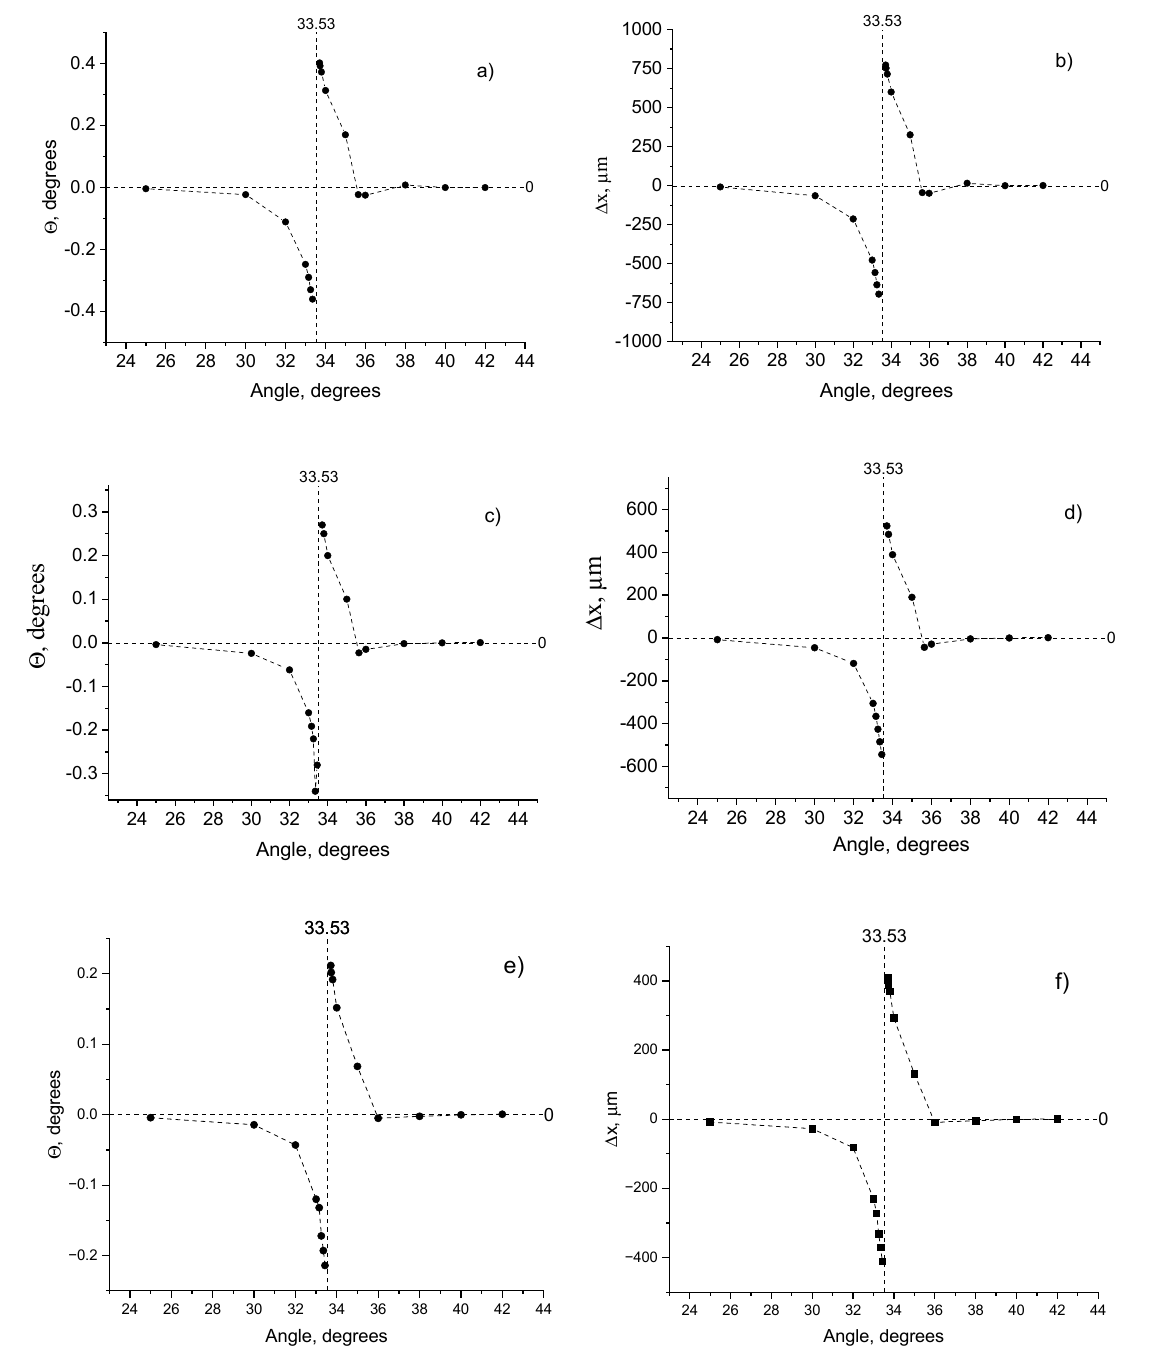
Figure 9. Calculated GH shifts (dots) as function of the incident angle: ( a , c , e )—angular shifts; ( b , d , f )—lateral GH shifts at z = 11 cm. h = 80 nm; FWHM = 20 µ m ( a , b ); FWHM = 26.64 µ m ( c , d ); FWHM = 32 µ m ( e , f ). The calculated dots are connected by the dashed line. Figure 10 shows the GH shifts depending on the angle of incidence for the grating depth that differs from the optimal one. It follows that the values of the angular GH shifts decrease significantly if the grating depth is not optimal for the effective coupling of the incident wave to the SP wave. In contrast to the case of the optimal depth h = 80 nm (Figure 9c,d), the GH shifts decrease by about 10 times. This indicates a significant role of SP resonance in the enhancement of the GH